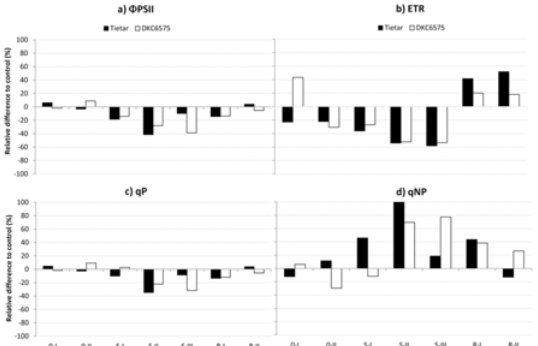
Fig 4. Percentage variation of the drought stress treatment (irrigation 0% of field capacity) with respect to the control (irrigation 100% of field capacity) for selected chlorophyll fluorescence parameters measured in the growth chamber experiment. The straight line at the “ 0 ” level represents the control, and histograms represent the relative variations of drought stressed plants.